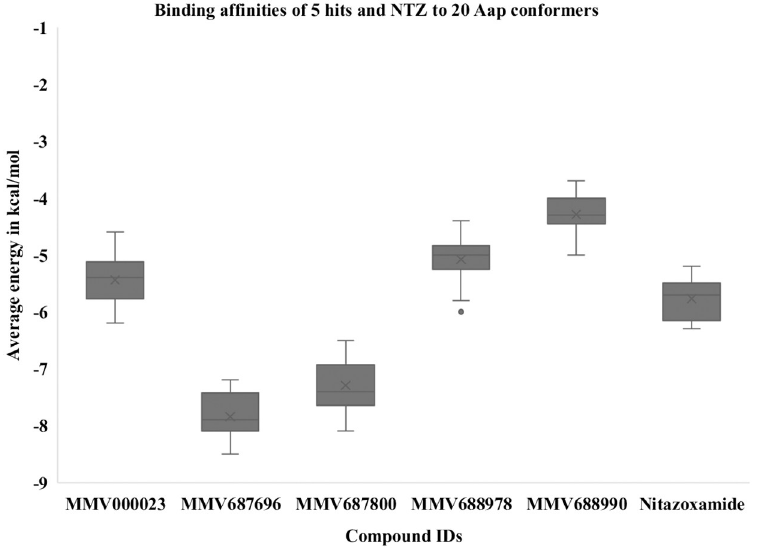
Fig 10. Average binding energy of 5 hits and NTZ to 20 conformers of Aap (kcal/mol). MMV687696 and MMV687800 demonstrated the highest binding affinity for the 20 Aap conformers. Error bars represent the range of values documented, with outliers depicted as dots.